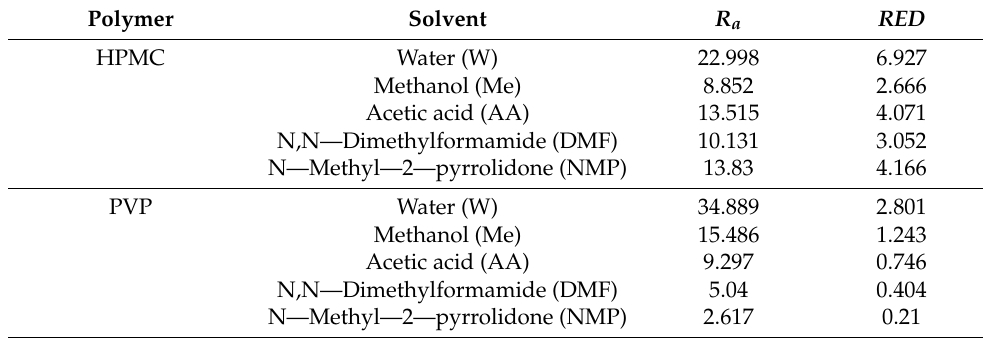
Figure 1. 3D representation used to plot solubility information for studied polymers with interaction radius, R 0 , compared to that of different solvents situated in same compatibility region. A schematic illustration of Hansen’s solubility sphere theory. Table 6. Parameters obtained by Hansen theory for systems HPMC/solvents and PVP/solvents, using modeling technique of 3D solubility: solubility parameter distance, R a , and relative energy difference, RED